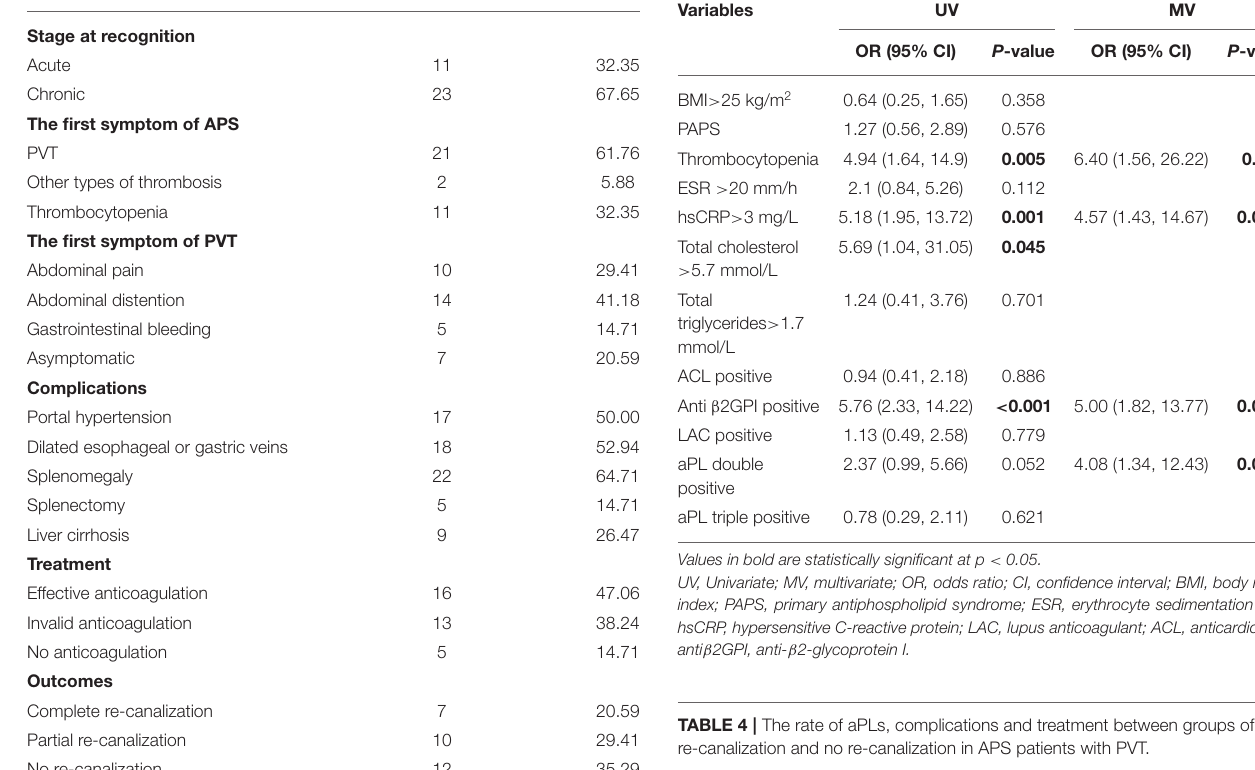
TABLE 4 | The rate of aPLs, complications and treatment between groups of re-canalization and no re-canalization in APS patients with PVT.